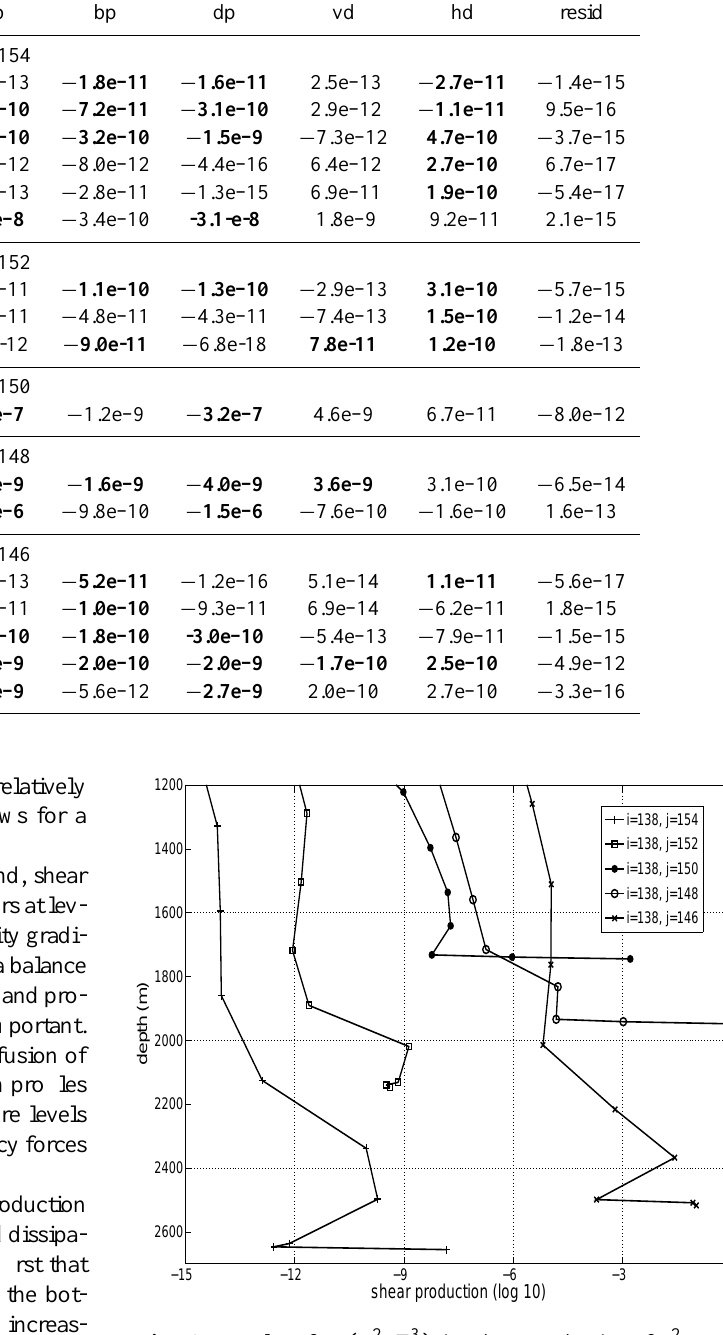
Fig. 10. Profiles of sp (m 2 s − 3 ), i.e. shear production of q 2 . Note Fig.10. Profilesofsp [ m 2 /s 3 ] , i.e.,shear production of q 2 . Notethat profilesareoffset asinFig.8. that profiles are offset as in Fig.